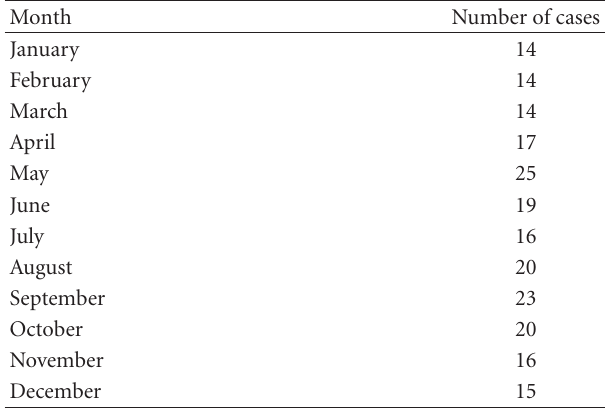
Table 3: Number of cases of elevated TSH levels on newborn screening by month of birth in the Northern Region of England,